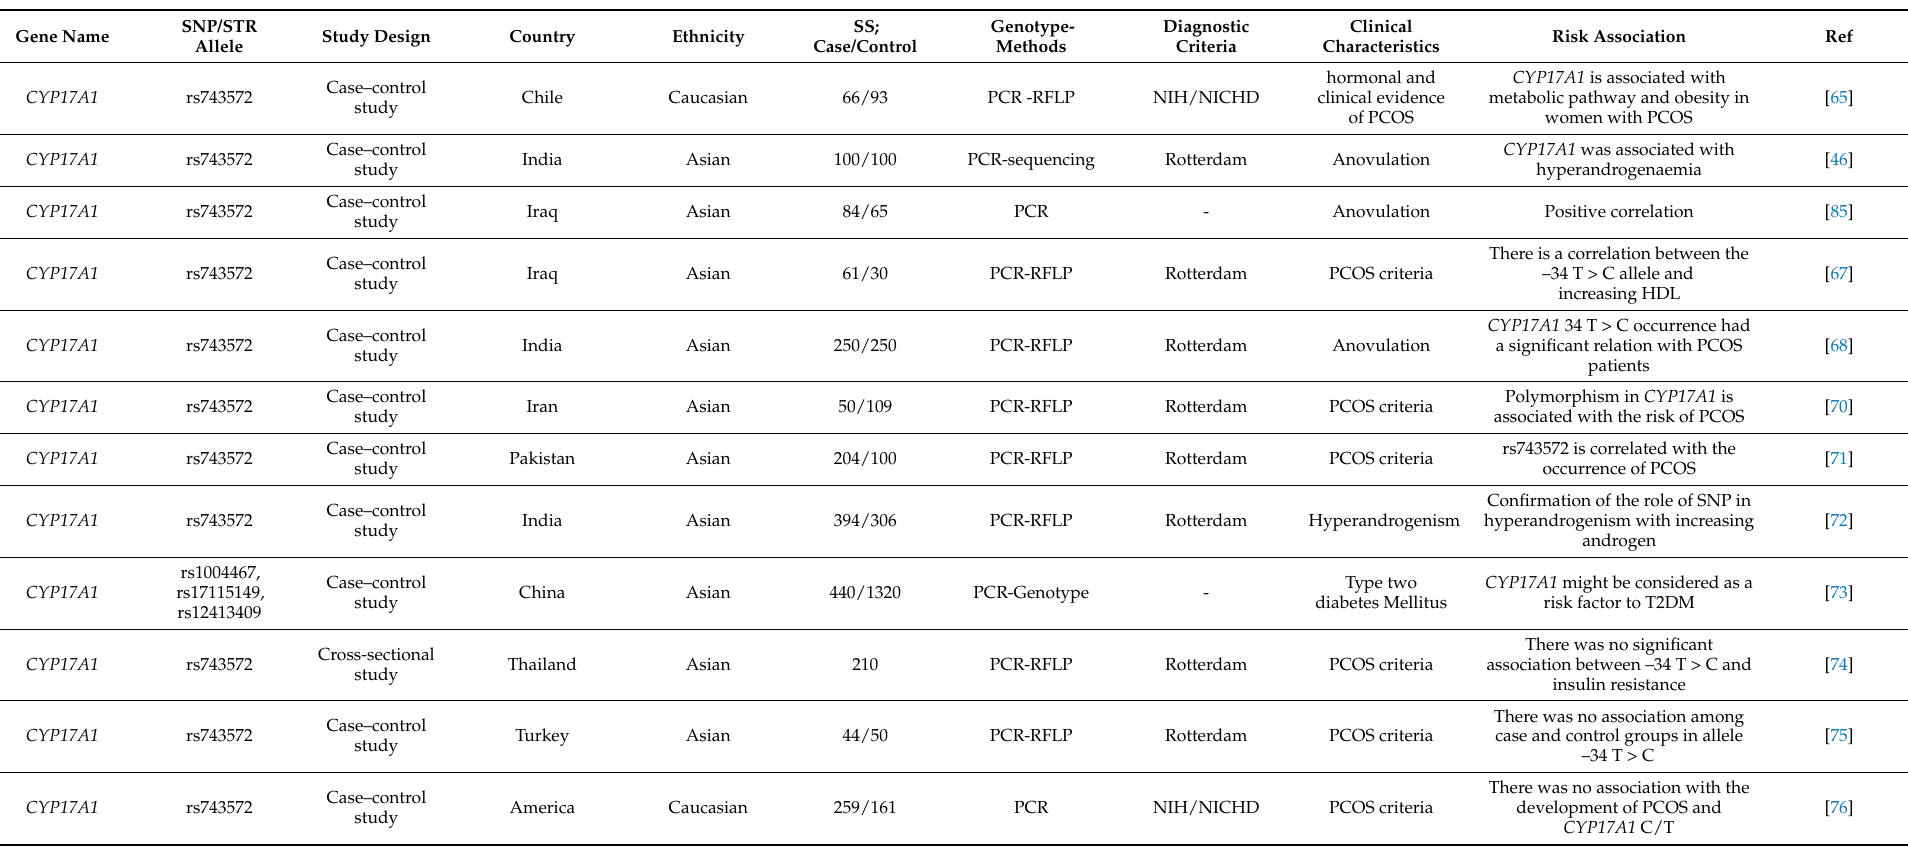
Table 2. Correlation between CYP17A1 genetic variants and PCOS with